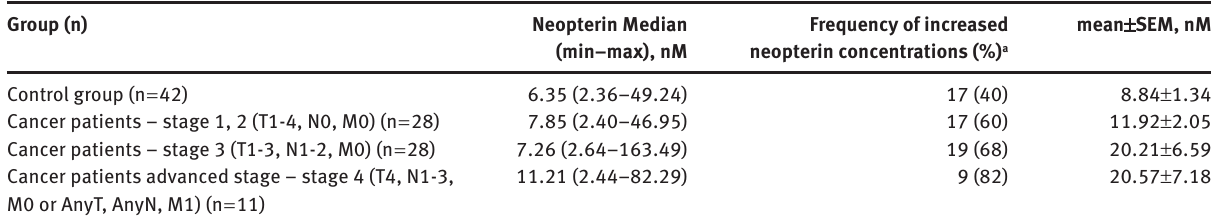
Frequency of increased (min–max), nM neopterin concentrations (%) a